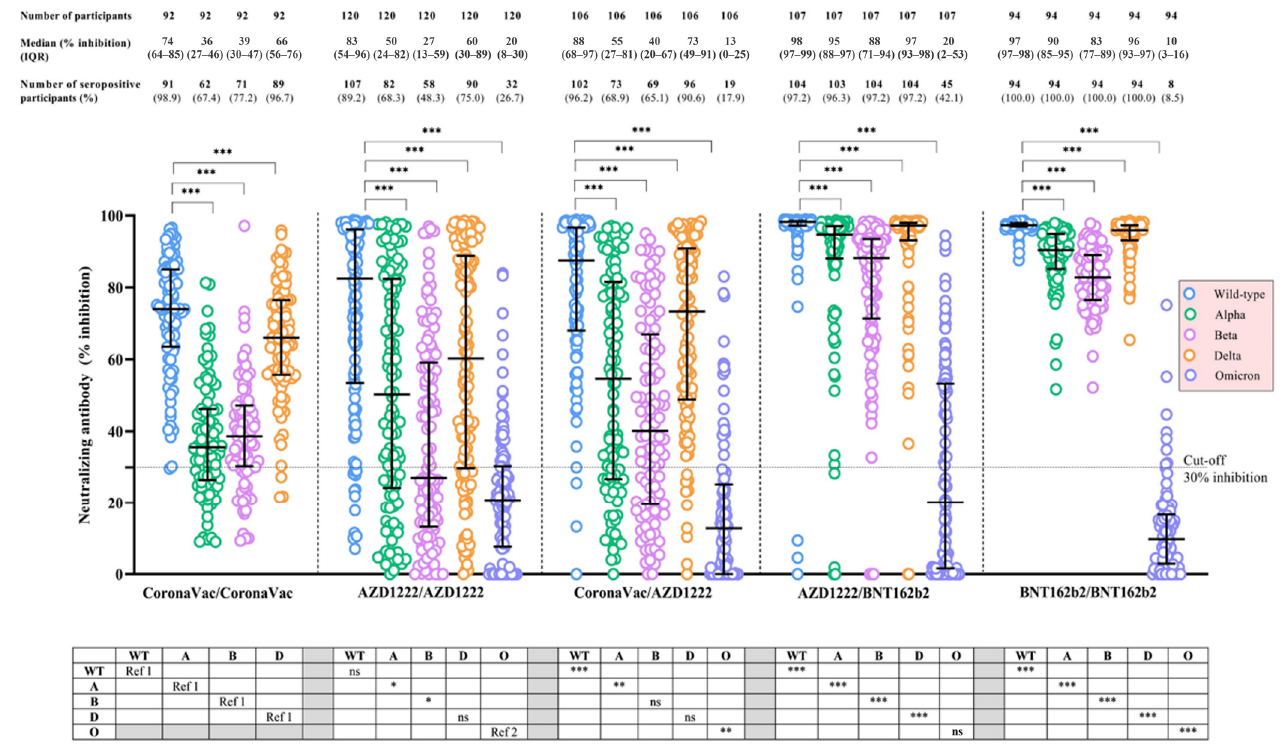
Figure 3. Neutralizing antibody, based on in-house surrogate virus neutralization test, against wild- type SARS-CoV-2 and other circulating variants of concern following the completion of a primary series of COVID-19 vaccination, stratified by the COVID-19 vaccine regimen. Data points are the reciprocals of individual participants. The median values of neutralizing antibody (NAb; in-house surrogate virus neutralization test) and the corresponding interquartile ranges (IQR) against wild- type SARS-CoV-2 and other circulating variants of concern following the completion of a primary series of COVID-19 vaccination are shown as black solid lines. Black dotted lines indicate the cut-off values. The Wilcoxon signed-rank test was performed to compare the medians of NAb between wild-type SARS-CoV-2 and the indicated variant of concern within each COVID-19 vaccine regimen, and the results are shown in the area above the figure. The median regression analysis was performed to compare the medians of NAb to wild-type SARS-CoV-2 or the indicated variant of concern between COVID-19 vaccine regimens, and the results are shown in the table below the figure. The comparisons of NAb-WT, NAb-Alpha, NAb-Beta, and NAb-Delta were conducted between the indicated COVID-19 vaccine regimen and the homologous CoronaVac regimen (the reference vaccine regimen, Ref 1), whereas the comparisons of NAb-Omicron were conducted between the indicated vaccine regimen and the homologous AZD1222 regimen (the reference vaccine regimen, Ref 2). * indicates p < 0.05; ** indicates p < 0.01; *** indicates p < 0.001; and ns indicates non-significant for the comparison of NAb between wild-type SARS-CoV-2 and the indicated variant of concern within each COVID-19 vaccine regimen and the comparison of NAb against the indicated variant of concern between vaccine regimens. Abbreviations: A, the SARS-CoV-2 Alpha variant; AZD1222 vaccine, the Oxford-AstraZeneca COVID-19 vaccine; B, the SARS-CoV-2 Beta variant; BNT162b2, Pfizer-BioNTech vaccine; COVID-19, coronavirus disease 2019; D, the SARS-CoV-2 Delta variant; IQR, interquartile range; NAb, neutralizing antibody; NAb-Alpha, neutralizing